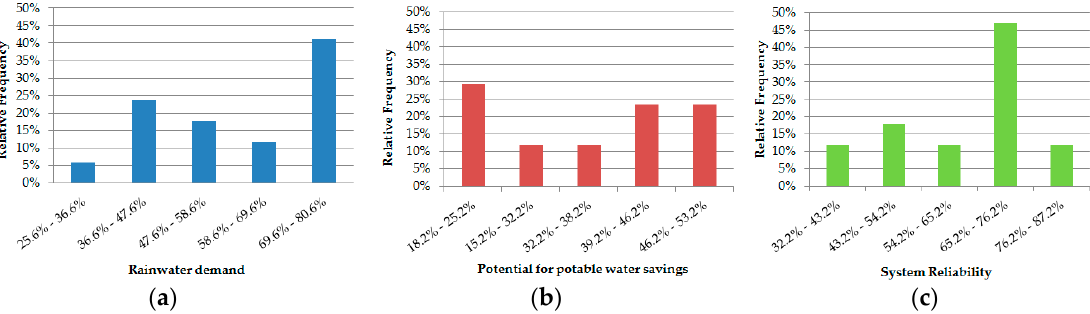
Figure 4. Histograms of ( a ) rainwater demand, ( b ) potential for potable water savings, and ( c ) system reliability, resulting from research data on rainwater harvesting in schools obtained from